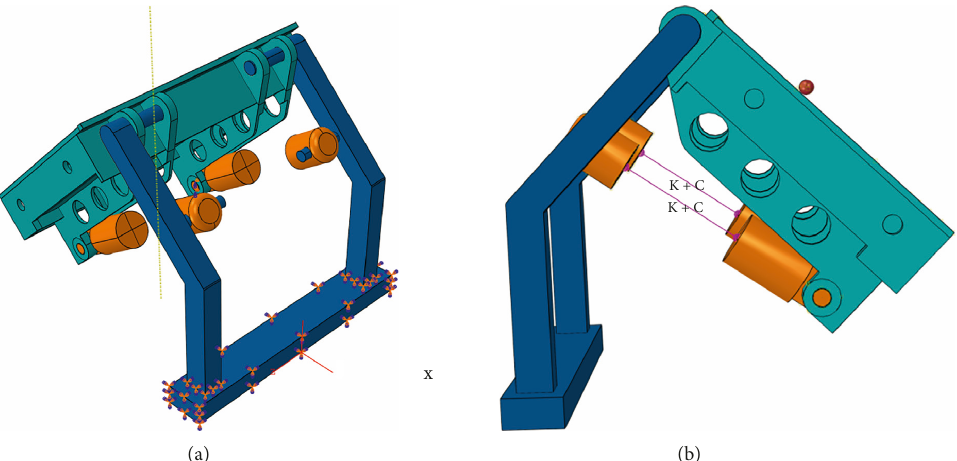
Figure 12: Settings of (a) the boundary conditions and (b) the equivalent